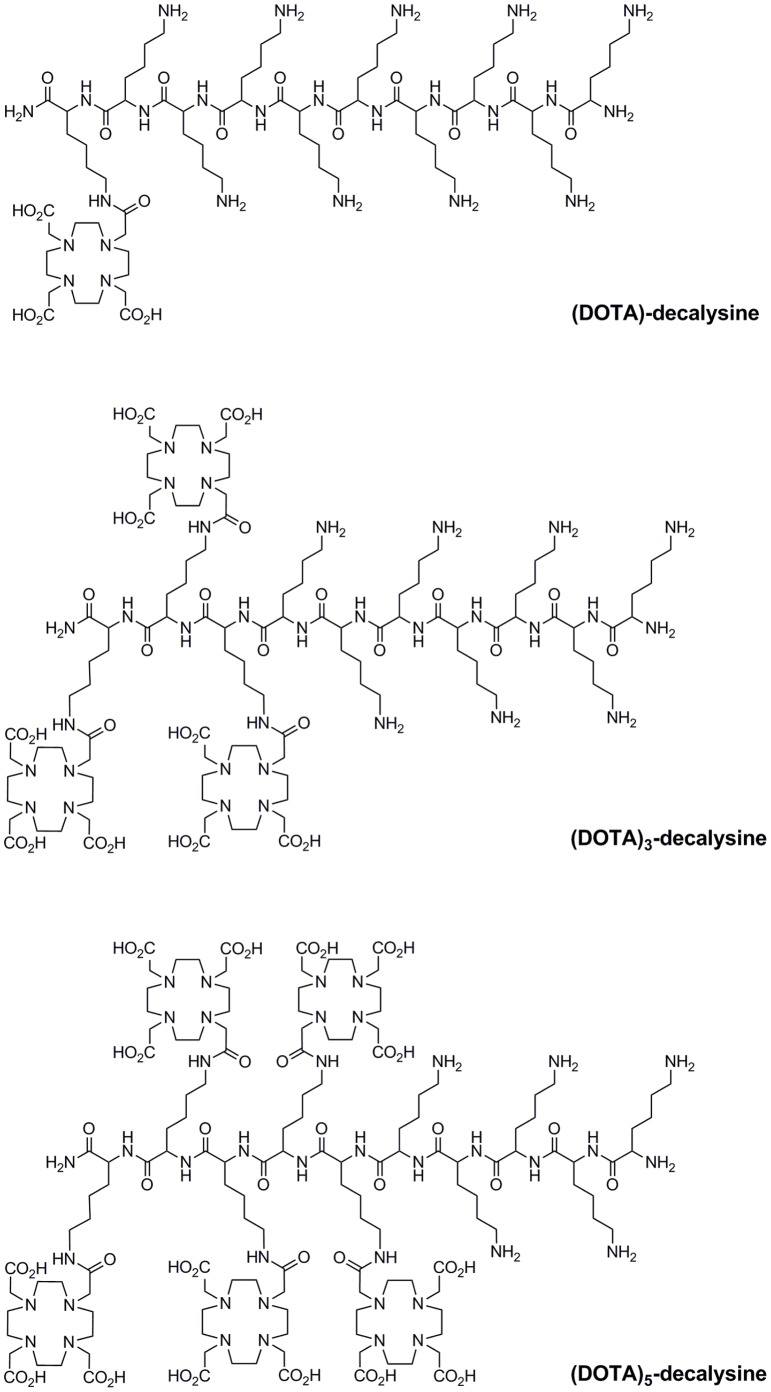
Structures of (DOTA)-decalysine, (DOTA)3-decalysine, and (DOTA)5-decalysine.